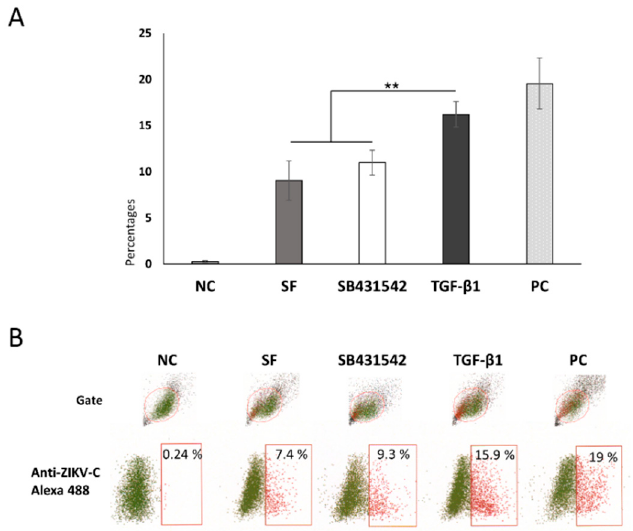
Figure 5. Enhancement of Zika virus binding to the trophoblast cells upon TGF- β 1 treatment via the Smad pathway. ( A ) Percentages of the ZIKV-positive cells in the virus binding assay determined by FCM analysis. The results are expressed as the mean ( ± SEM) of at least triplicate experiments in each group, and the graph is representative of three independent experiments. **, p < 0.01. ( B ) Representative images of flow cytometry analysis. Numbers displayed inside each panel correspond to the percentage of the cells positive for ZIKV capsid protein of the parent-gated population. The results are expressed as the mean ( ± SEM) of at least triplicate experiments in each group, and the graph is representative of two independent experiments. **, p < 0.01.